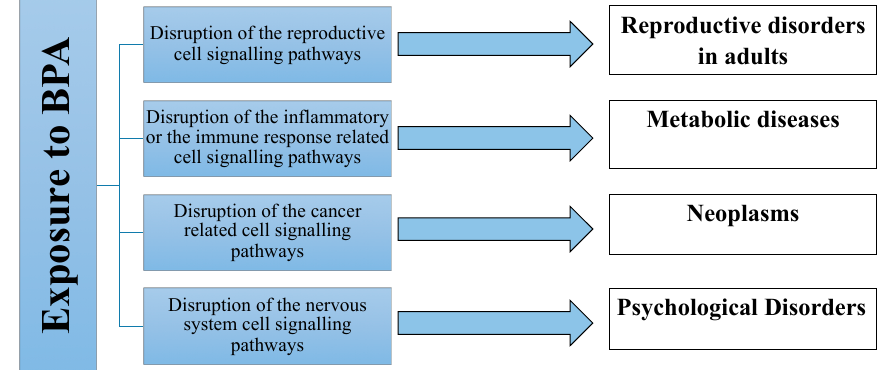
Figure 1. Main clinical bisphenol A (BPA) exposure-associated diseases.